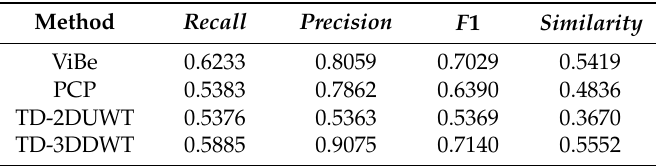
Table 10. Comparison of average metrics for the airport sequence.